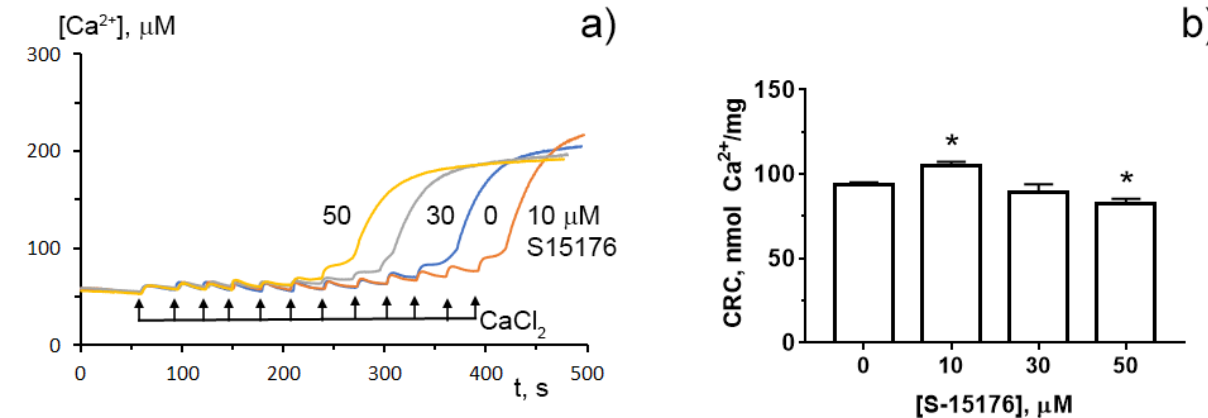
Figure 5. Typical changes in the external (Ca 2+ ) upon the successive addition of 10 µ M CaCl 2 pulses to the suspension of rat liver mitochondria in the presence of S-15176 (10, 30, and 50 µ M) or 0.1% DMSO (0 µ M S-15176); ( a ) The action of S-15176 difumarate salt on the calcium retention capacity index of rat liver mitochondria; ( b ) The index reflects maximum Ca 2+ overload of mitochondria that occurs immediately before the MTP pore opening. Data represent the mean ± SEM ( n = 5). * p <